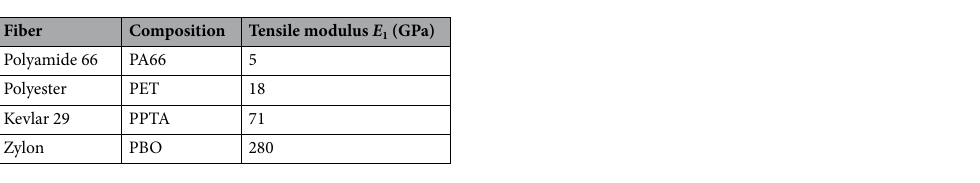
Table 3. The tensile modulus of the reinforced fibers 24 .